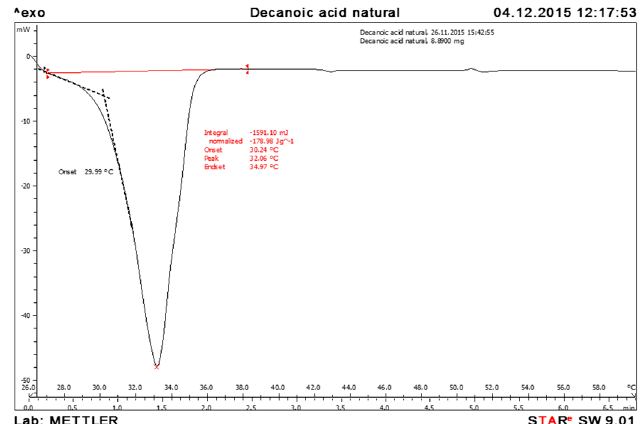
Figure A4. Decanoic acid natural DSC test curve.